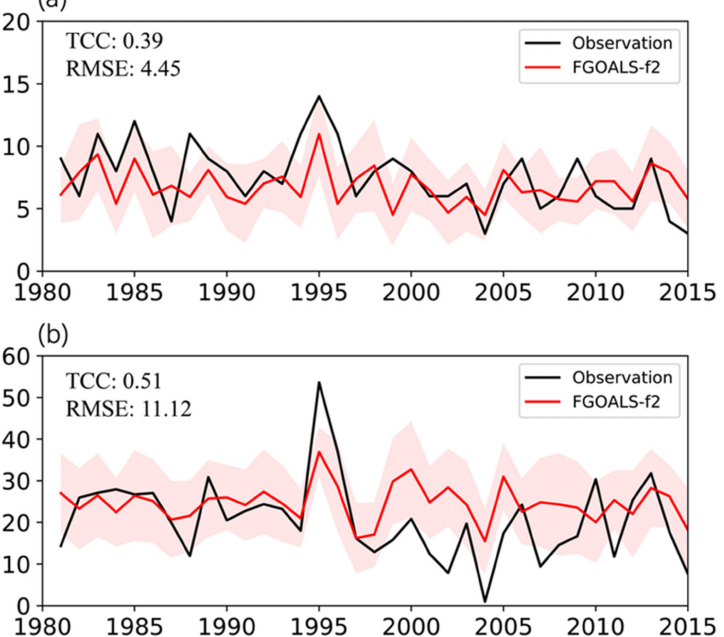
Figure 2. The interannual variability in the number of TCs ( a ) and the accumulated cyclone energy (ACE) of TCs ( b ) in the SCS from July to November during 1981–2015. The International Best Track Archive for Climate Stewardship (IBTrACS) dataset (black line) is compared with the results predicted by the FGOALS-f2, which include the result with ensemble mean (red line) and the spread (defined by the standard deviation) based on the 24 ensembles (red area). The temporal correlation coefficient (TCC) and root mean square error (RMSE) of the interannual variability of the number and ACE of TC between the IBTrACS and FGOALS-f2 are also